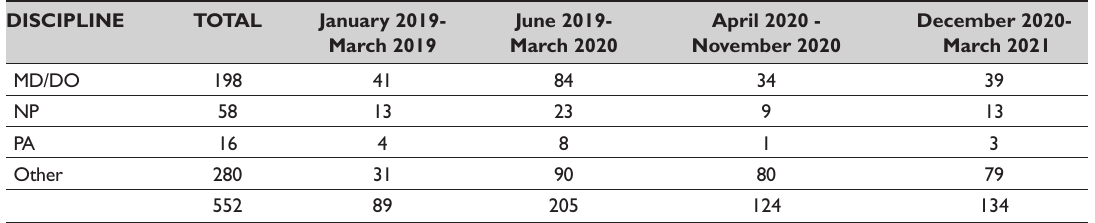
Table 1: Total number of health care providers detailed by discipline and time period DISCIPLINE